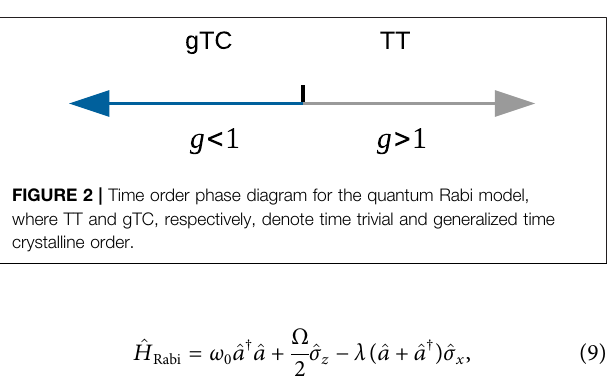
FIGURE1 | Timeorder phase diagram for spin-1 atomic BEC, where TT and gTC, respectively, denote time trivial and generalized time crystalline order. The region of (hashed) line segments surrounding c 2 = 0 for the non- interacting system is to be excluded.